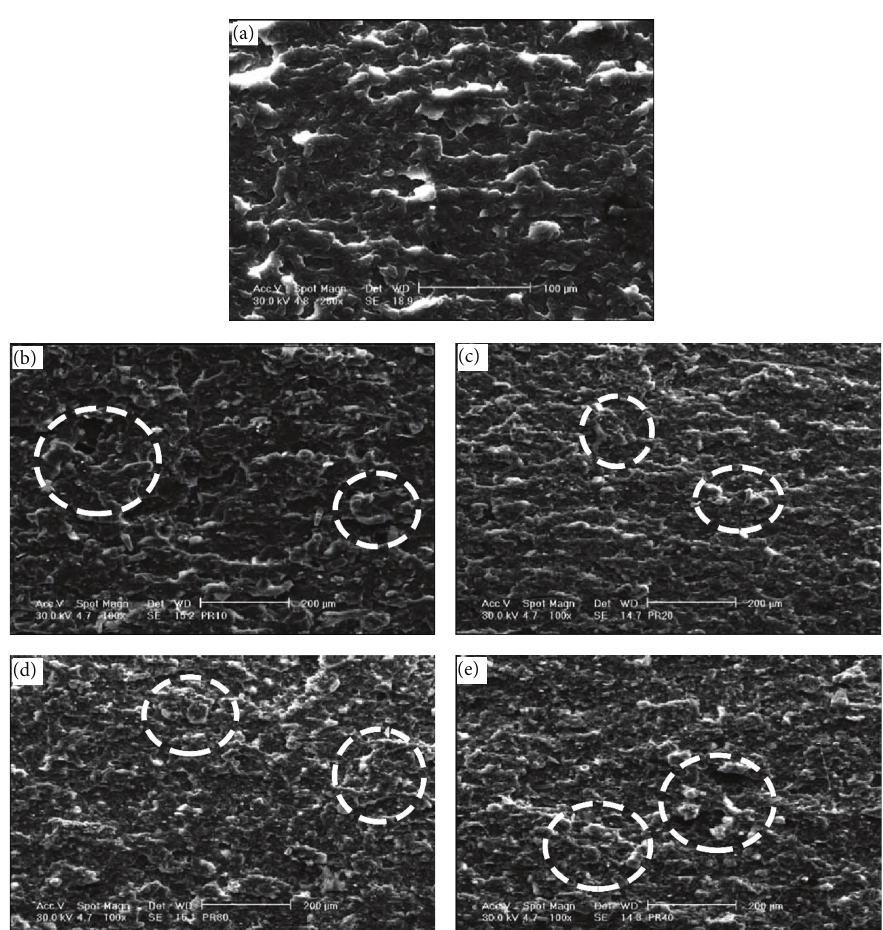
Figure25:SEMmicrographsofimpactfracturesurfacesof(a)unfilledunmodifiedPVC-U;(b)RHfilledimpactmodifiedPVC-Ucomposites at 10, (c) 20, (d) 30, and (e) 40 phr of RH content